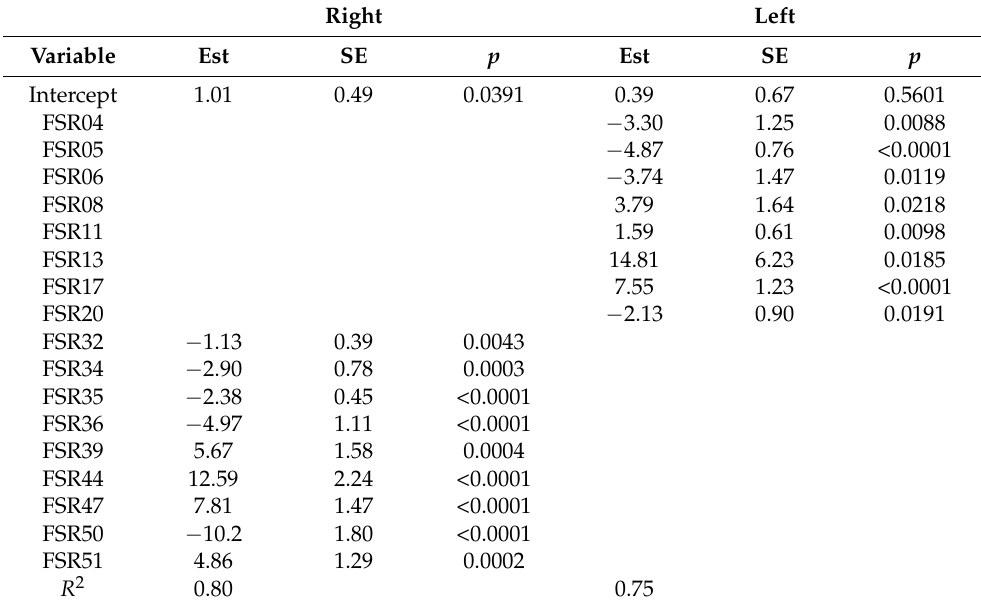
Table 5. Regression models based on plantar pressure for two heights. Right Left Variable Est SE p Est SE p Intercept